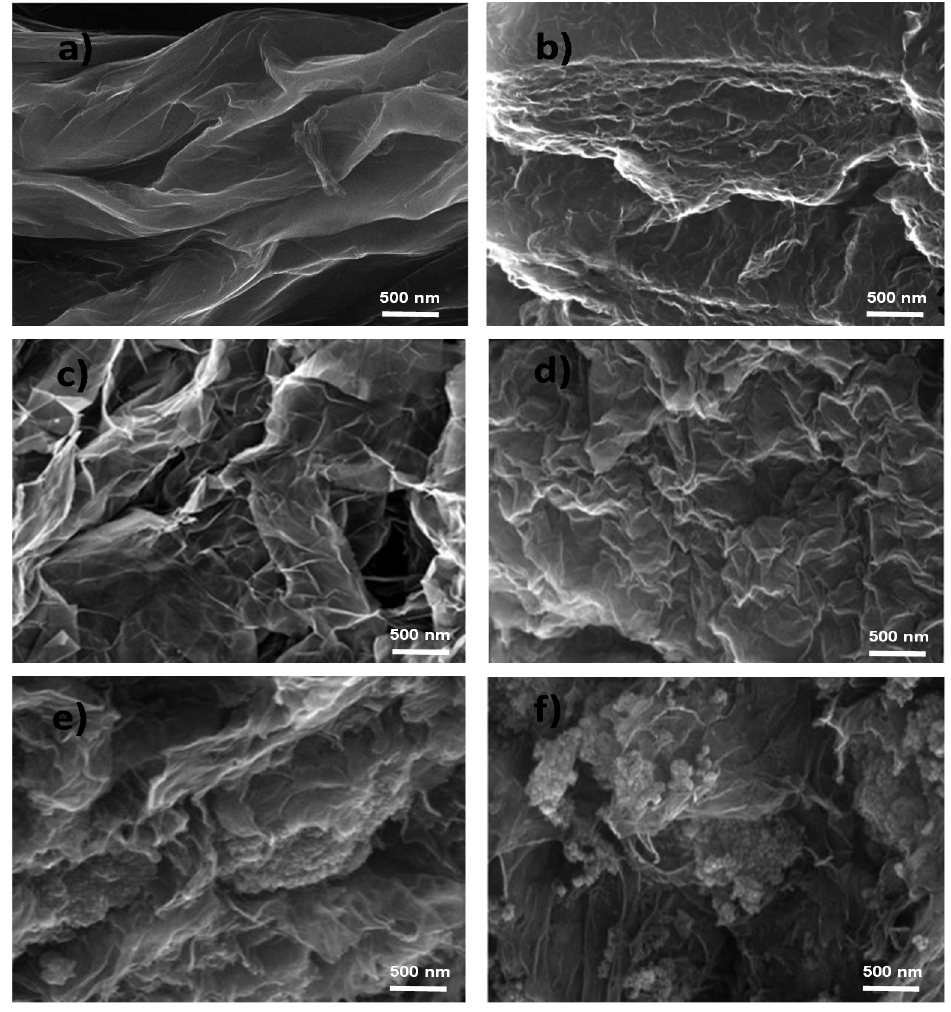
Figure 1. Representative SEM images of EGO 14 ( a ), EGO 15 ( b ), EGO 5 ( c ), reference GO * ( d ), EGO 2 ( e ), and EGO 21 ( f ).